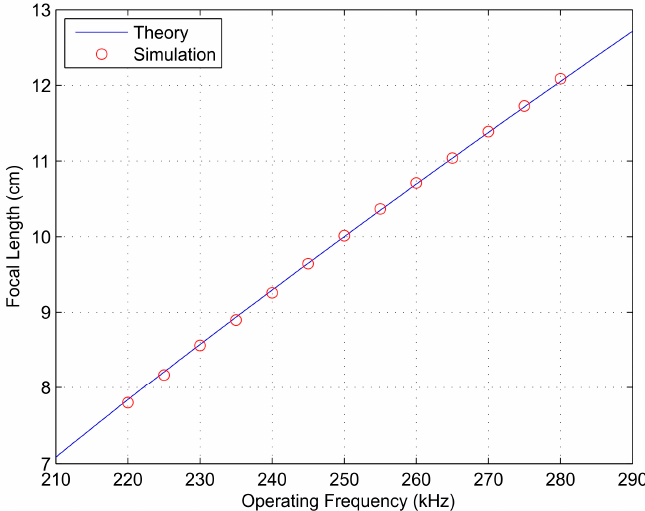
Figure 3. Focal length against operating frequency: theory (blue solid line) and simulation (red dots).